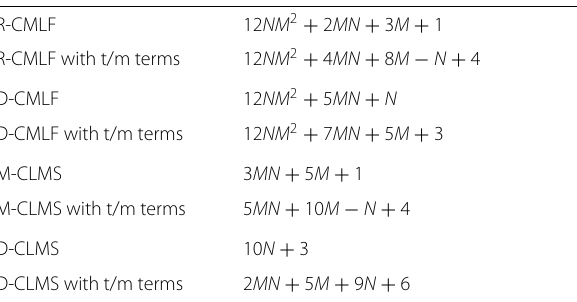
the corresponding lattice identification filter